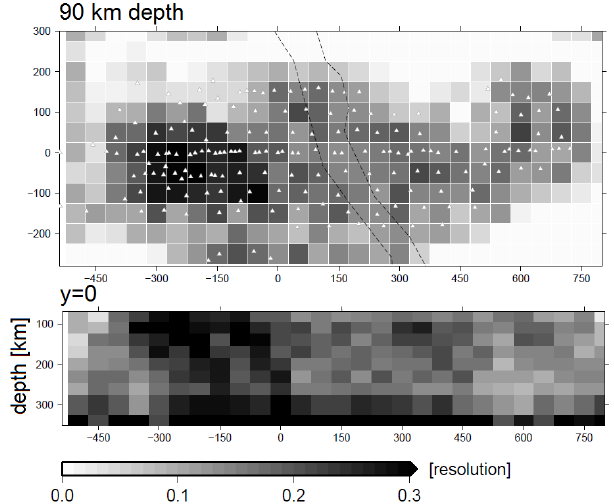
Figure 8. Diagonal elements of the resolution matrix in horizontal slice at 90km depth and vertical slice along the main transect of the study area. The low and high values of resolution indicate poorly resolved and well-resolved areas, respectively. Triangles mark seis- mic stations. Dashed lines indicate the